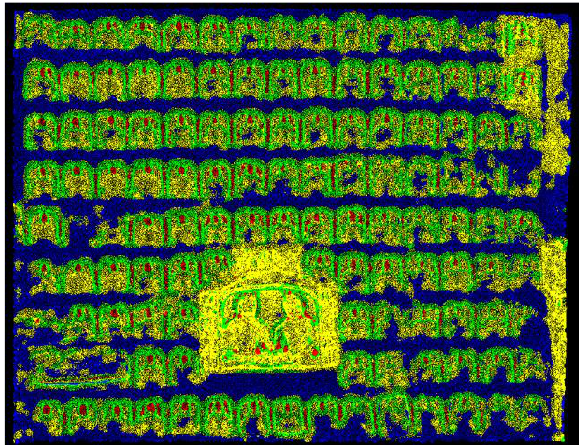
Figure 7. Classification result of grotto point cloud after feature selection